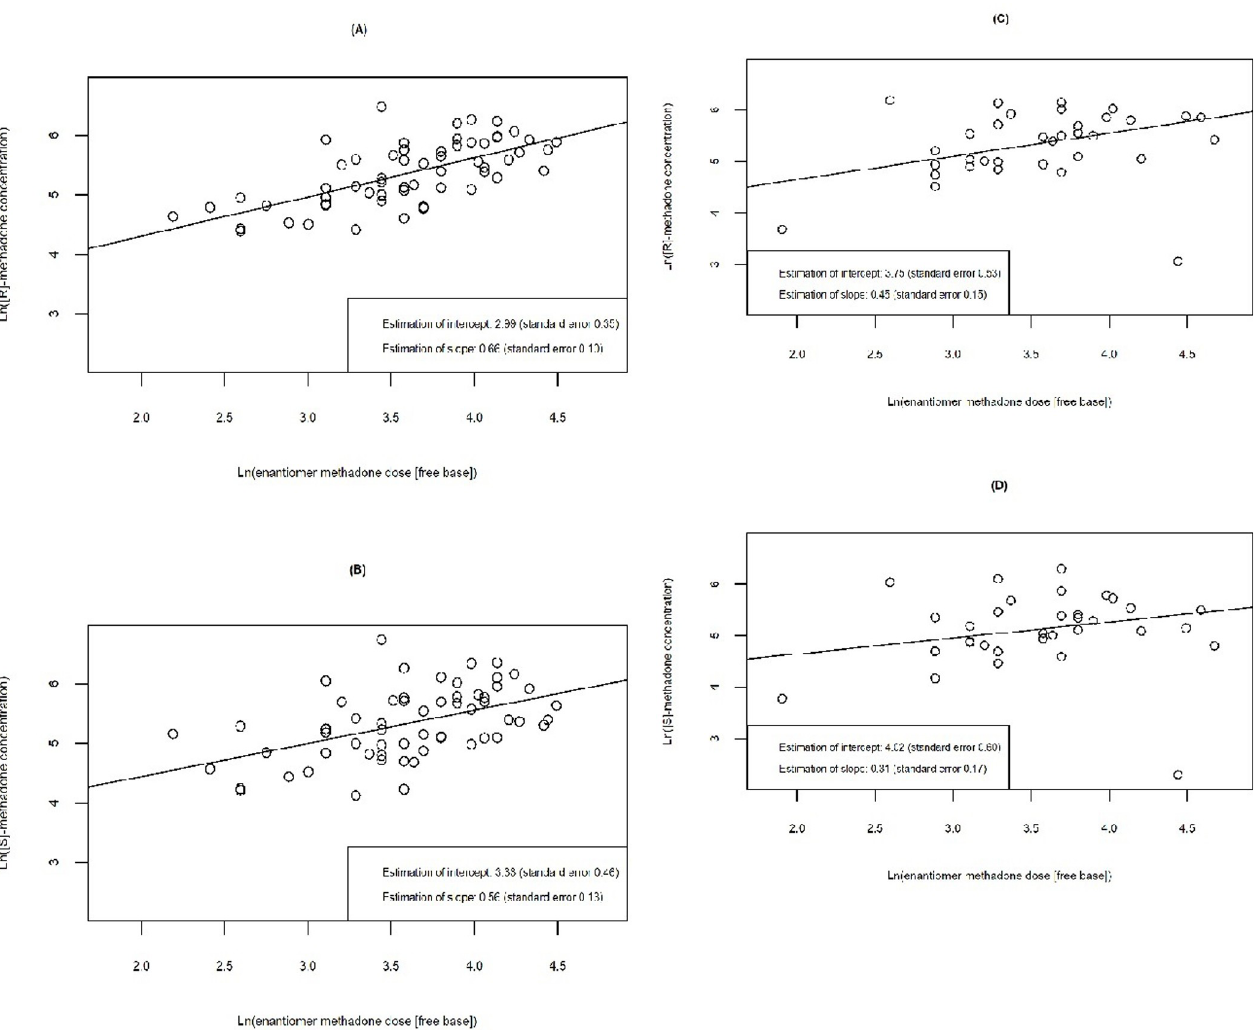
Fig 3. Linear relationship between ln(methadone concentration) and ln(methadone dose) by enantiomer and CYP2B6 genotype function. In both LOF and normal function participants, (R)- and (S)-methadone concentration increases by 2.71 mg per increase in enantiomer methadone dose [i.e., one unit increase in ln(enantiomer methadone dose)]. In LOF participants, (A) average (R)-methadone concentration increases by 1.93 ng/ml [ln(R-methadone concentration) increases by 0.66, standard error 0.10], and (B) average (S)-methadone concentration increases by 1.75 ng/ml [ln(S-methadone concentration) increases by 0.56, standard error 0.13]. In normal function participants, (C) average (R)-methadone concentration increases by 1.57 ng/ml [ln(R-methadone concentration) increases by 0.45, standard error 0.15] and (D) average (S)-methadone concentration increases by 1.36 ng/ml [ln(S-methadone concentration) increases by 0.31, standard error